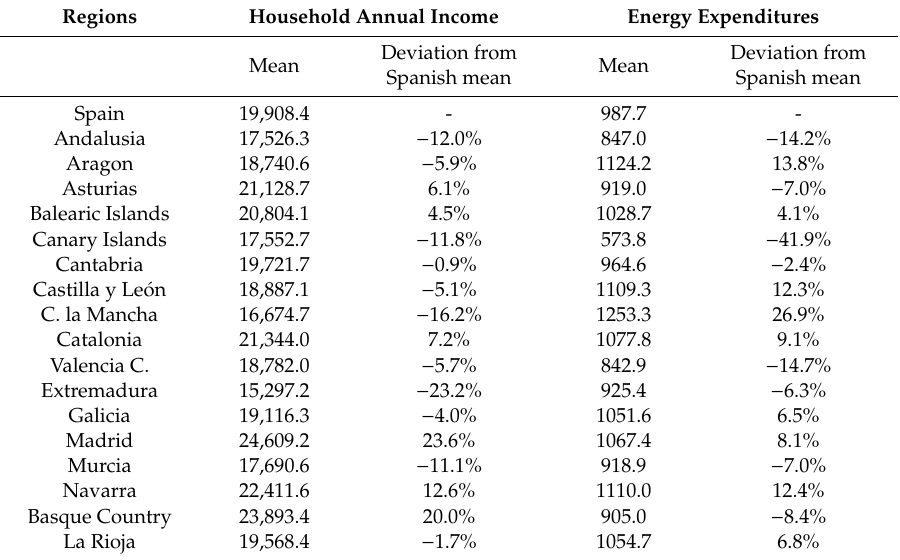
Table 3. Household annual income and energy expenditure in Spain and by Autonomous Regions. Means for the period 2006–2016 ( € per